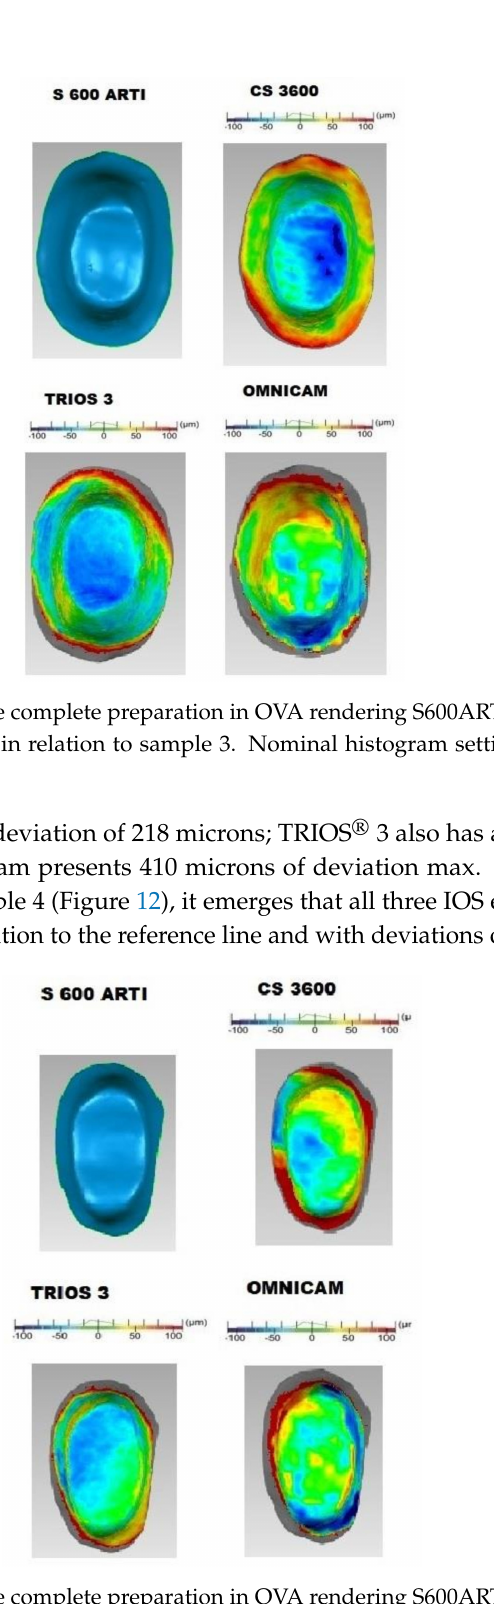
Figure 12. Comparison of the complete preparation in OVA rendering S600ARTI and 3D comparison analysis for IOS with saliva in relation to the sample 4. Nominal histogram settings ± 25 microns and critical ± 100